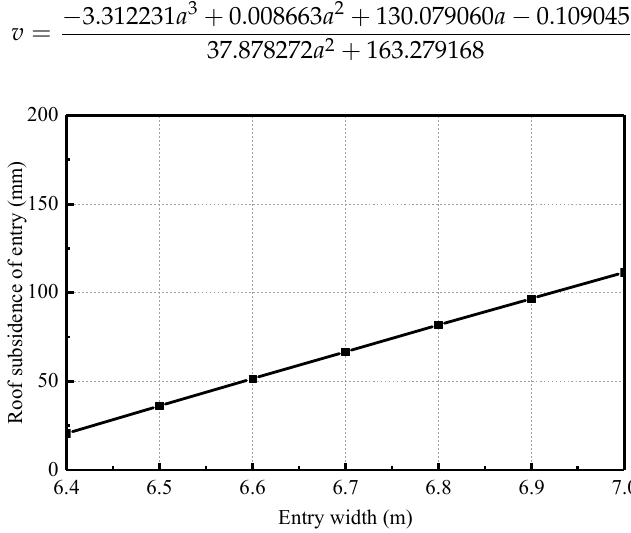
Figure 6. Relationship between roof subsidence and the width of the gob-side entry.